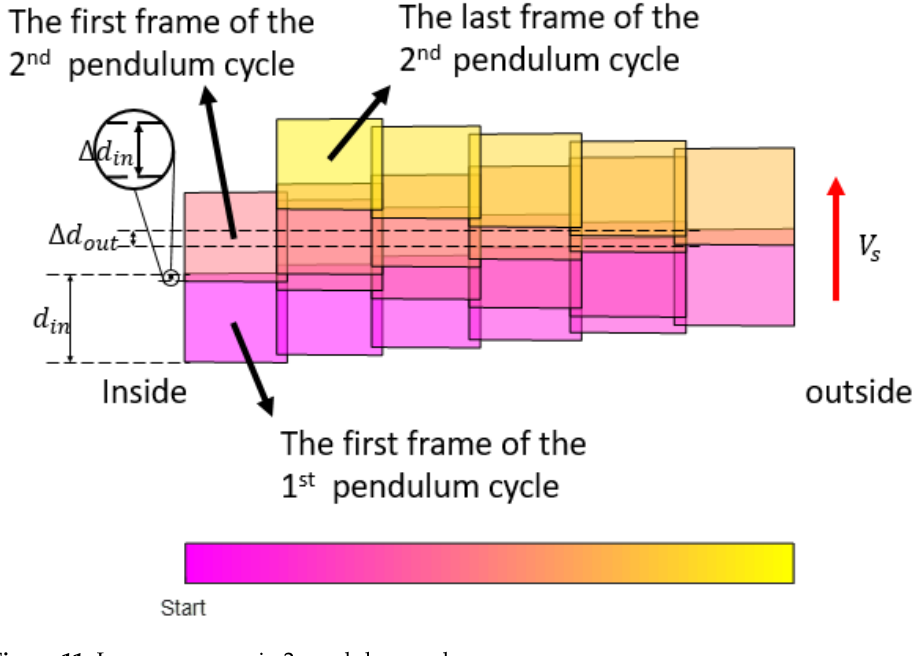
Figure 11. Image coverage in 2 pendulum cycles.